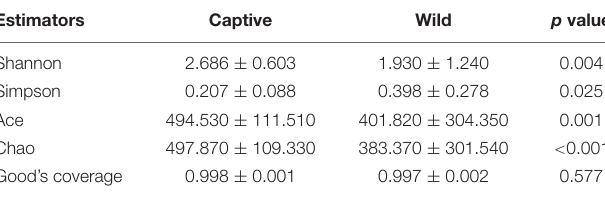
TABLE 1 | Alpha diversity index of the gut microbiota in Tokay gecko. Estimators